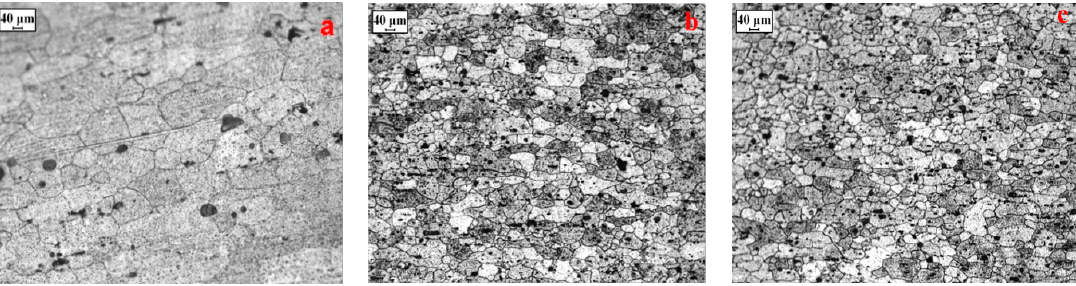
Figure 6. Microstructures of samples: ( a ) matrix; ( b ) LP ‐ treated (1.8 J + 25 °C); ( c ) WLP ‐ treated (1.8 J + 120 °C).